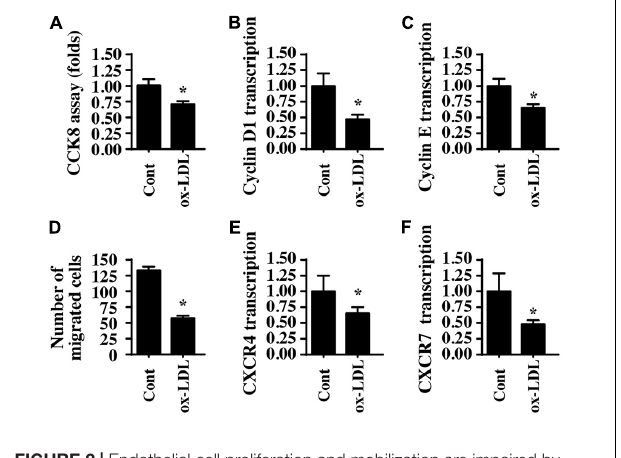
FIGURE 2 | Endothelial cell proliferation and mobilization are impaired by ox-LDL. (A) Cell growth was measured through the CCK-8 assay. (B,C) The transcription of cyclin D1 and cyclin E was determined through qPCR. (D) A transwell assay was used to observe the cell migration response. (E,F) RNA was isolated from ox-LDL-treated endothelial cells and the levels of CXCR4 and CXCR7 were determined through qPCR. * p <